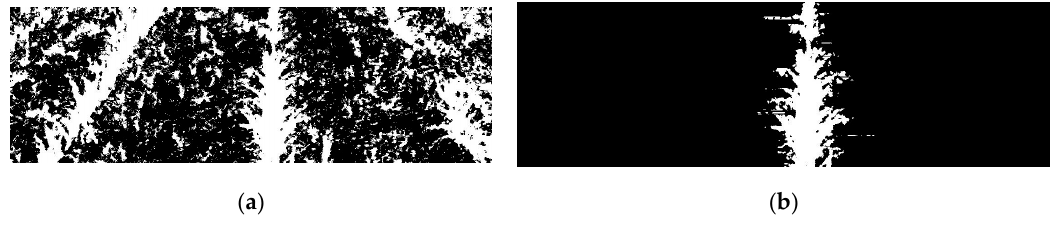
Figure 7. ( a ) Segmented image. ( b ) Central crop row detected by applying the proposed detection method to Figure